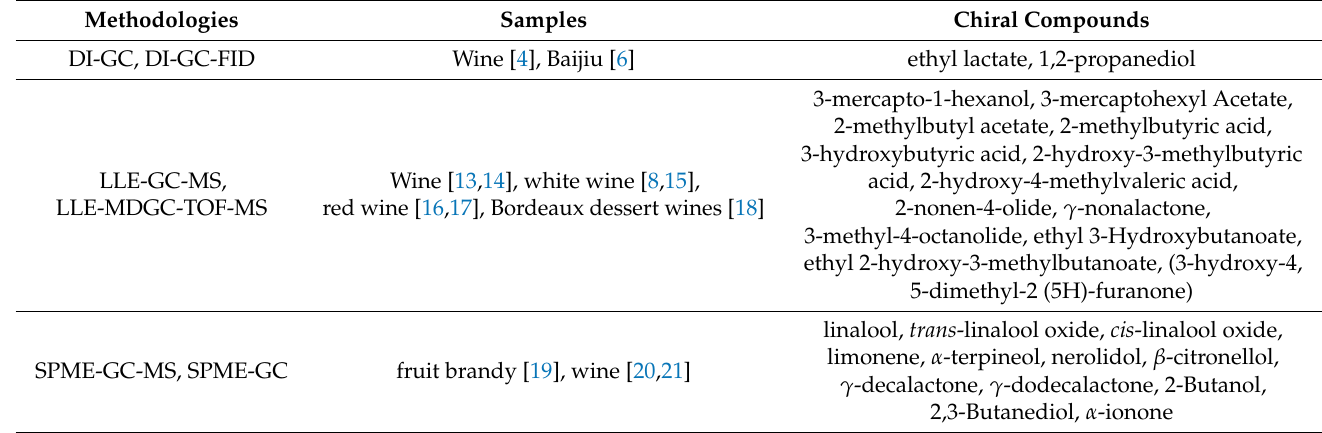
Table 1. The respective methodologies of analysis for chiral compounds of alcoholic